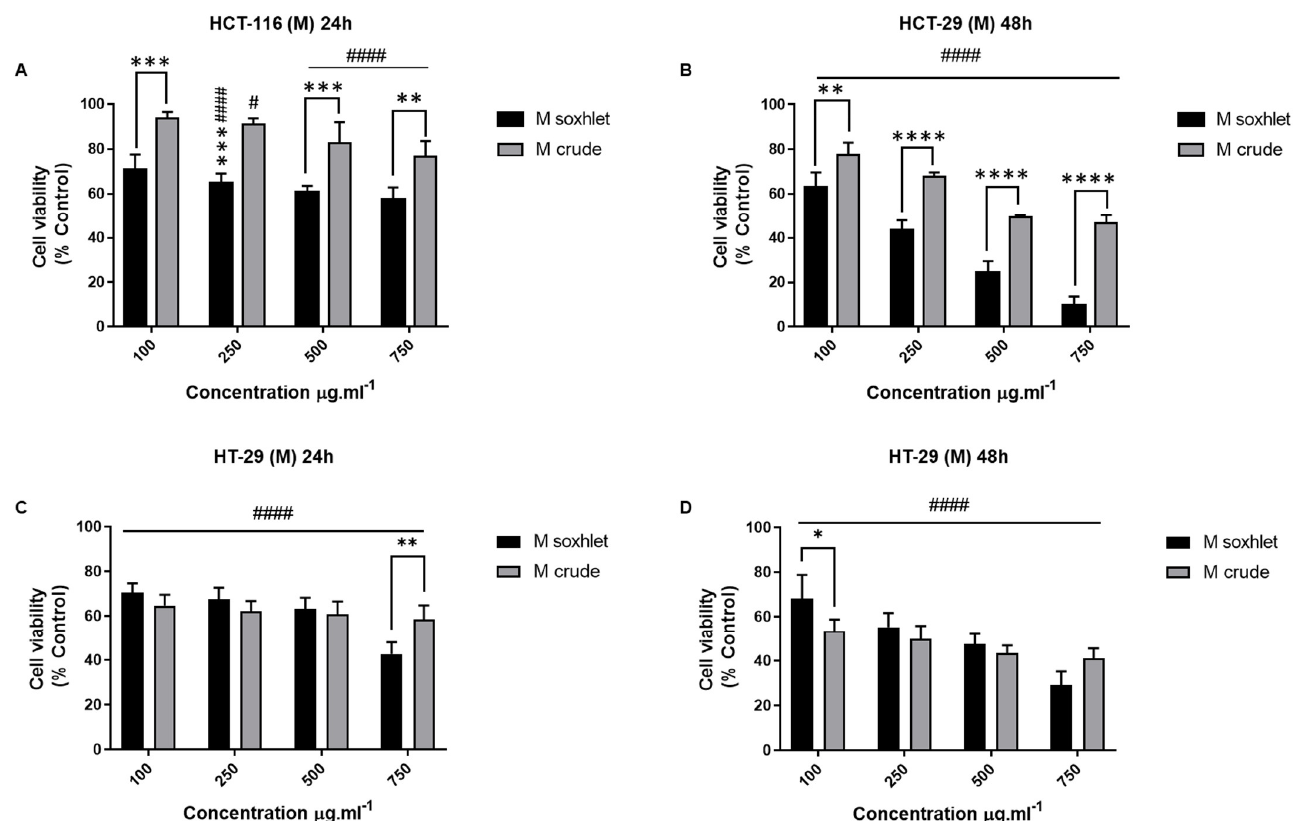
Figure 5. Effect of M extracts on the viability of CRC cell lines. HCT-116 and HT-29 cells were seeded in 96-well plates and treated subsequently with different concentrations of M